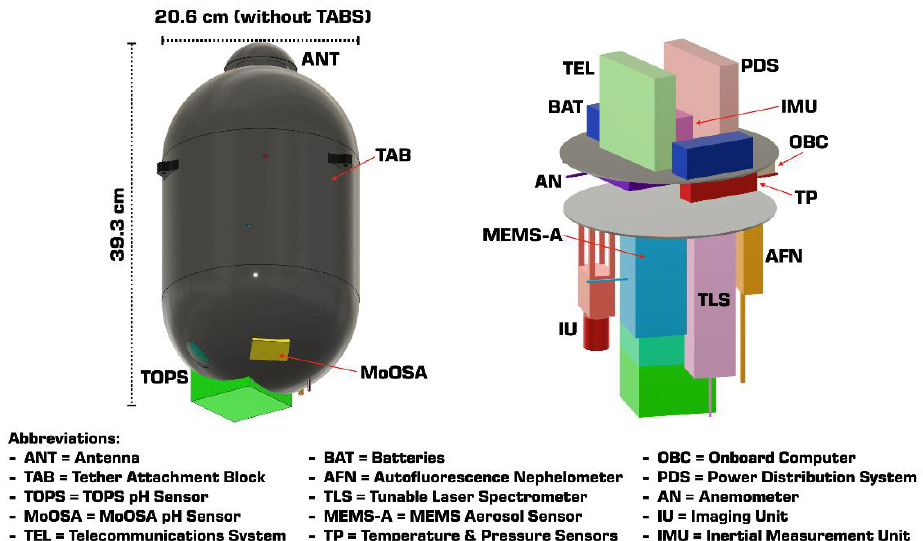
Figure 4. Concept design for the VLF Habitability parachute probe Habitability Mission.